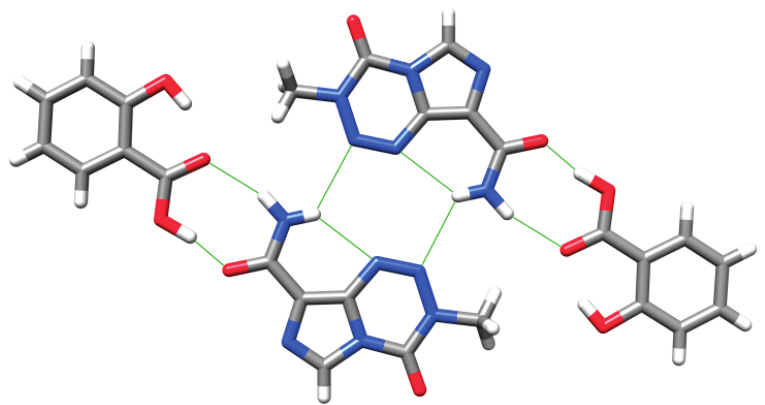
Figure 8. Temozolomide–salicylic acid co-crystal [35]. Strong H-bonds are shown in